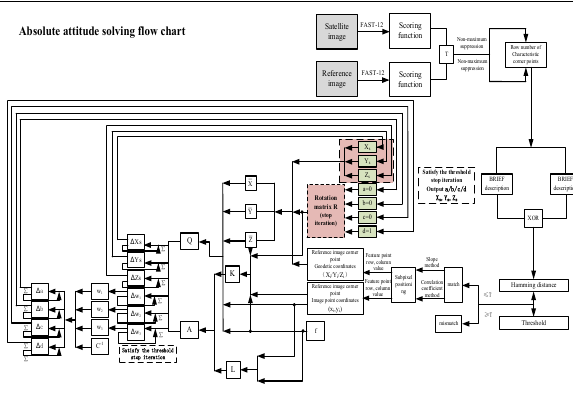
Figure 3. Cloud detection data processing flow chart